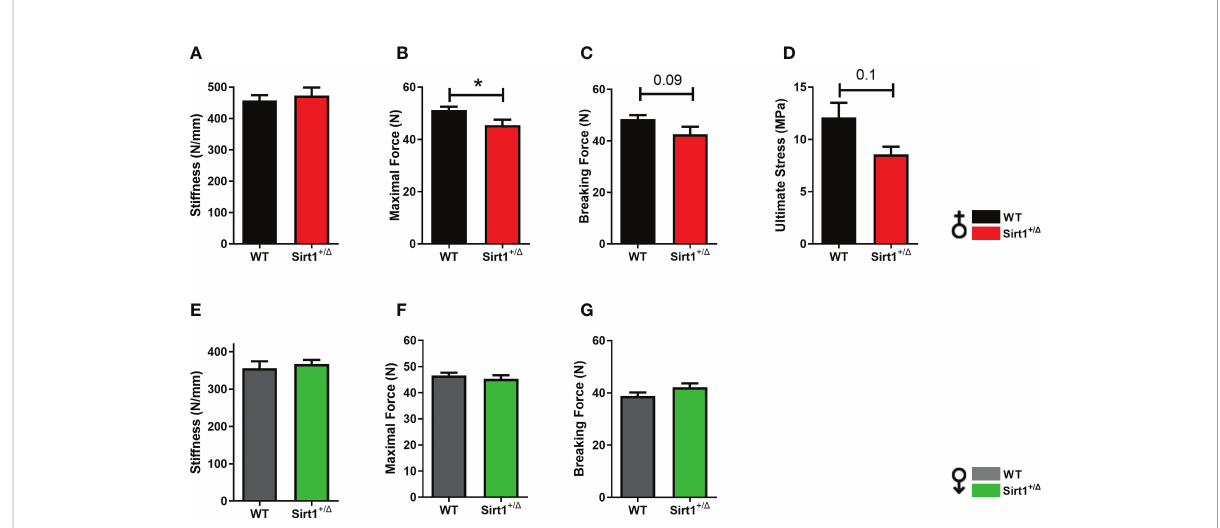
FIGURE 5 Sirt1 haploinsuf fi ciency leads to reduced femoral biomechanical properties in female but not male Sirt1 +/ D mice. Biomechanical properties determined by three-point bending in 7-month-old female (A – D) and male (E – G) Sirt1 +/ D and WT mice. (A, E) . Stiffness (N/mm). (B, F). Maximal (Ultimate) force (N). (C, G) . Breaking force (N). (D) Ultimate Stress (MPa). Results are mean ± SEM. Analyzed by unpaired Student ’ s t -test. * P < 0.05 versus WT mice. (n = 8